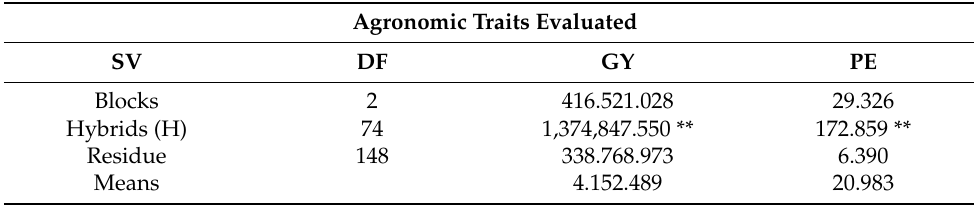
Table 5. Summary of analysis of variance and average estimates of evaluated agronomic